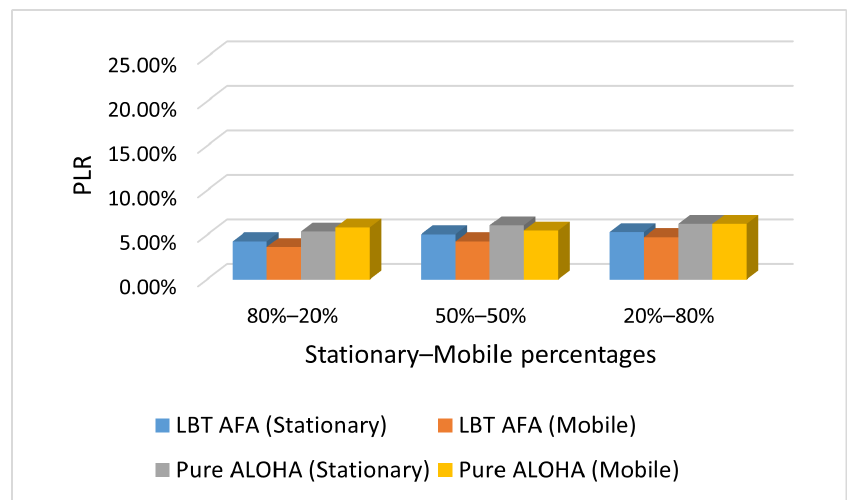
Figure 7. Case L: PLR with varying percentages of stationary and mobile end-devices.